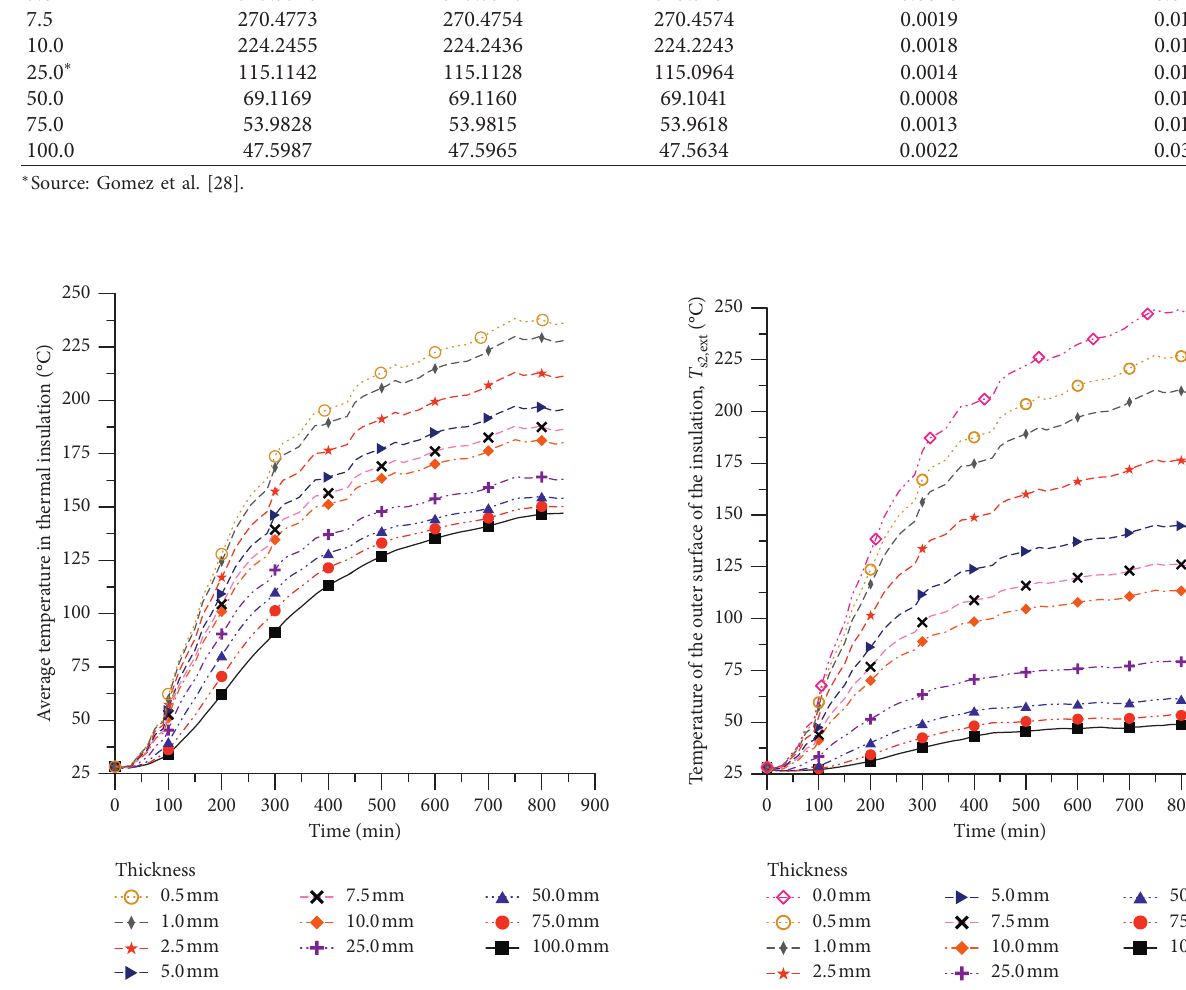
Figure 6: Average temperature in thermal insulation during the heating process for different ceramic fiber thicknesses.